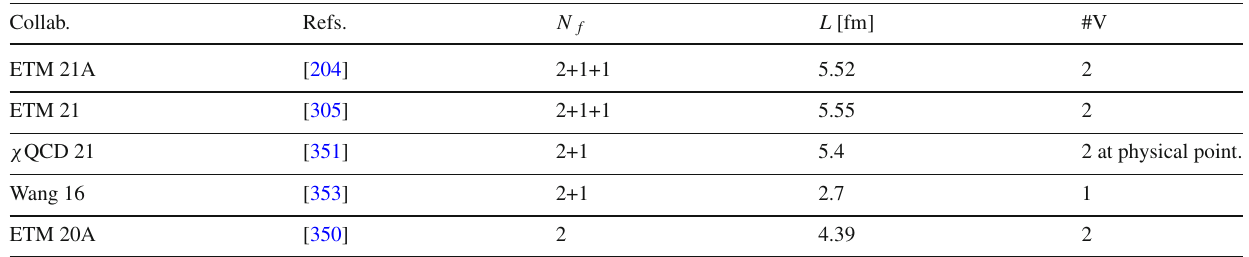
Table 118 Finite-volume effects in determinations of the low-energy constants related to the vector form factor of the pion Collab. Refs.